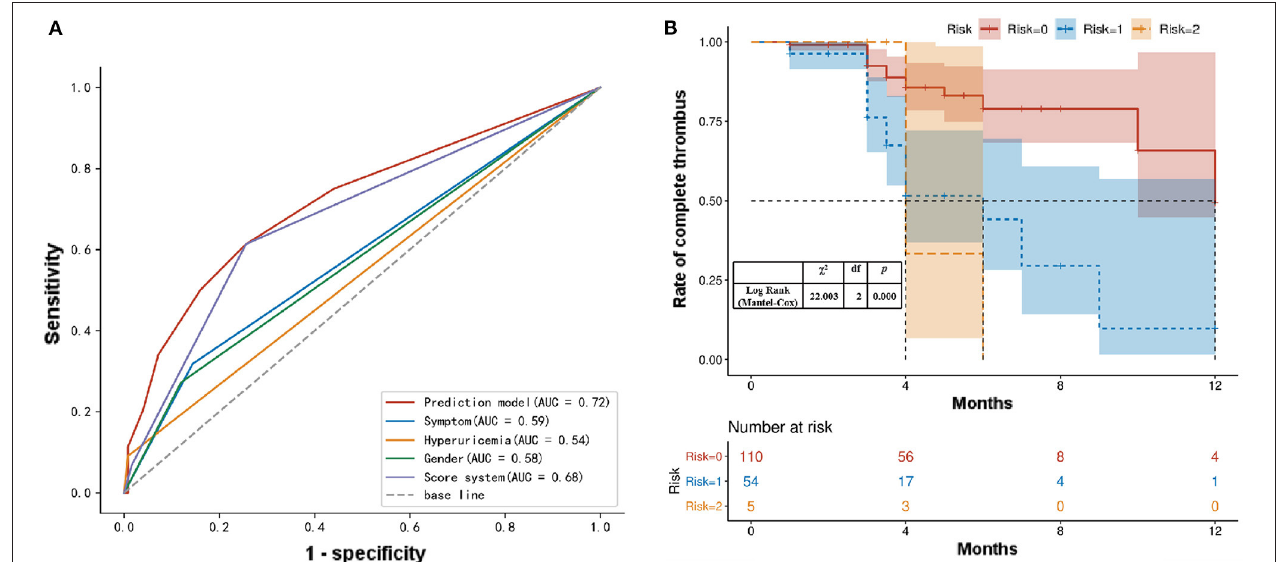
FIGURE 4 | (A) ROC analysis of the sensitivity and specificity of the predictive value of a scoring system for AAA patients with EVAR. ROC, Receiver operating characteristic; AAA, abdominal aortic aneurysms; EVAR, endovascular aortic repair. (B) Kaplan–Meier analysis for the complete thrombosis rate according to the risk